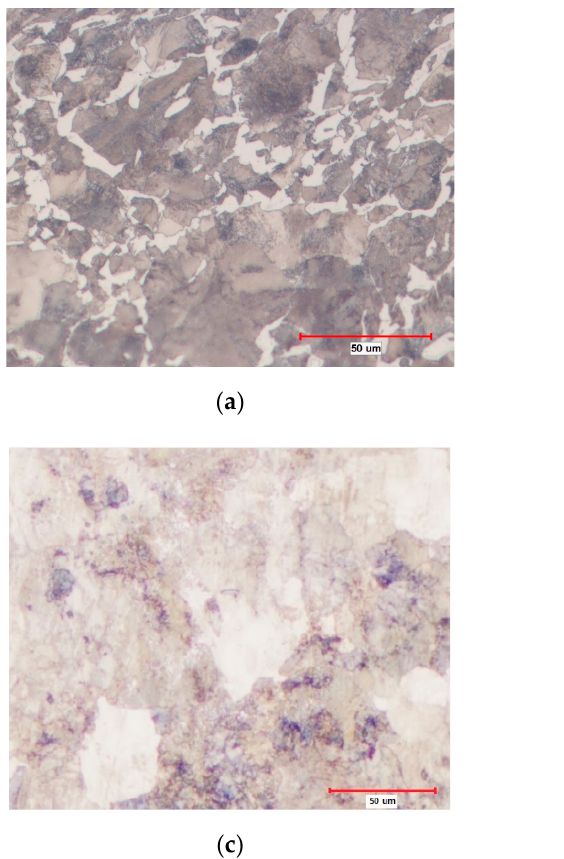
Figure 2. Microstructure of wheels and rails: ( a ) R7 ‐ wheel; ( b ) RSW ‐ wheel; ( c ) UIC ‐ rail; ( d ) KS60 ‐ rail.